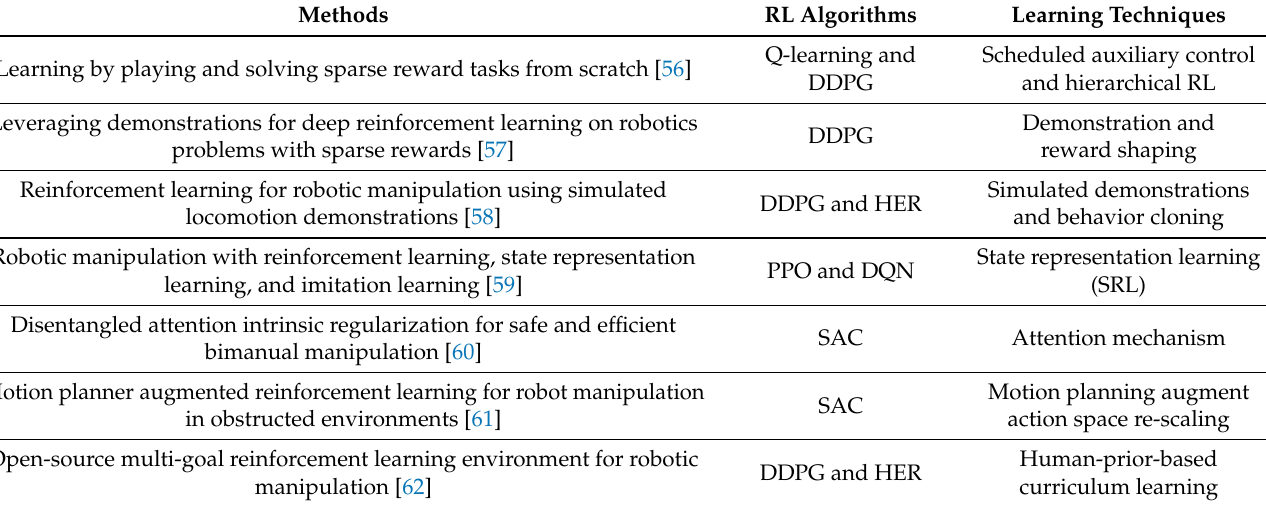
Table 4. A list of papers about sim-to-real implementation relative to RL Algorithms and learn- ing